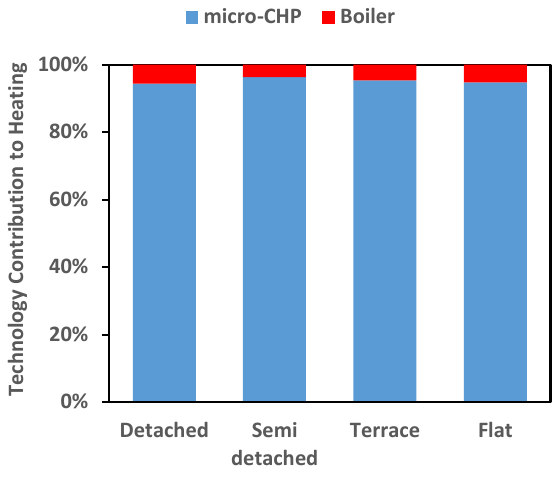
Figure 5. Incentivised design (Feed in Tariff (FIT)) without TES.